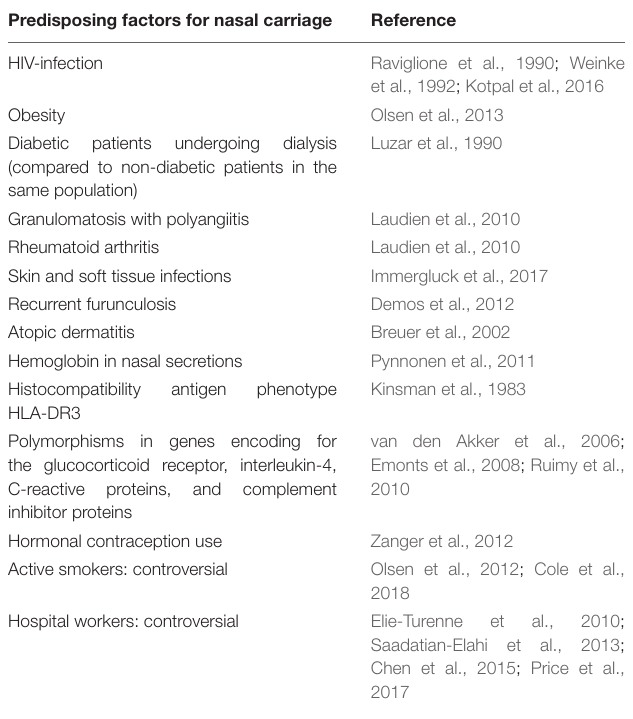
TABLE 2 | Predisposing factors for nasal